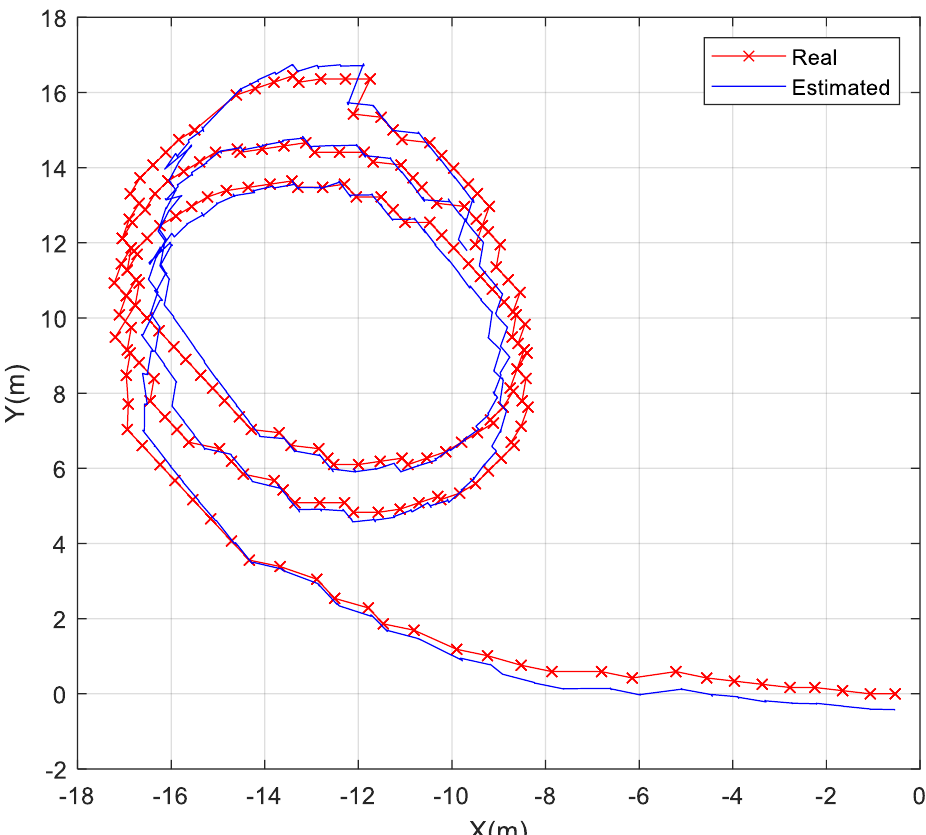
Figure 9. Experimental and estimated trajectory for data set turning 1.